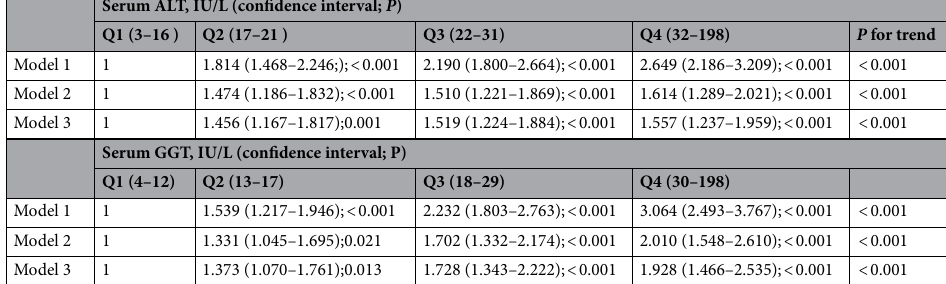
Table 3. Hazard ratios for developing impaired fasting glucose by serum alanine aminotransferase and gamma-glutamyltransferase at baseline in longitudinal analysis. Model 1, unadjusted; Model 2, after adjustment for age, gender and body mass index;Model 3, model 2 plus after adjustment for log-transformed weekly alcohol consumption, current smoker, hypertension, hyperlipidemia, and uric acid. Q1 1st quartile, Q2 2nd quartile, Q3 3rd quartile, Q4 4th quartile.